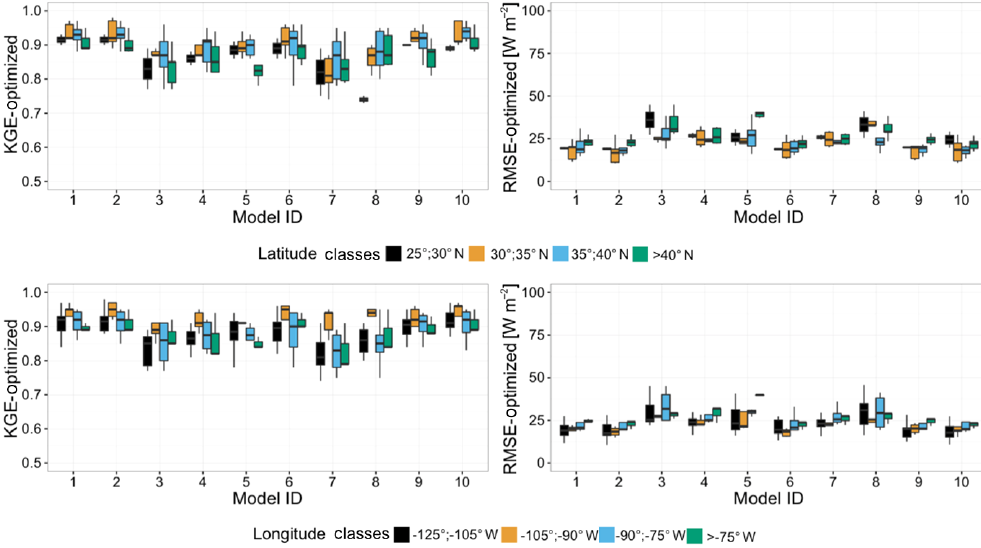
Figure 5. KGE (best is 1) and RMSE (best is 0) values for each optimized formulation in clear-sky conditions, grouped by classes of latitude and longitude. Only values of KGE above 0.5 are